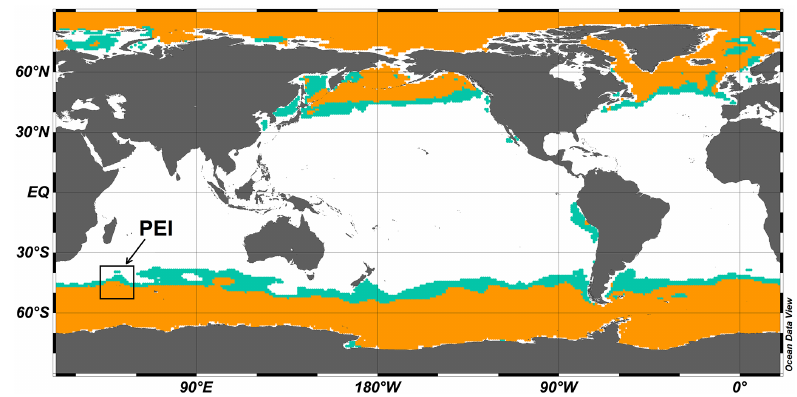
Figure 9. Surface area exposed to at least month-long (blue) and annual-mean (orange) aragonite undersaturation in the year 2100 under RCP8.5. The blue region represents ∼ 23 × 10 6 km 2 . The area labelled PEI represents the pteropod study region of Hunt et al. (2008) around the Prince Edward